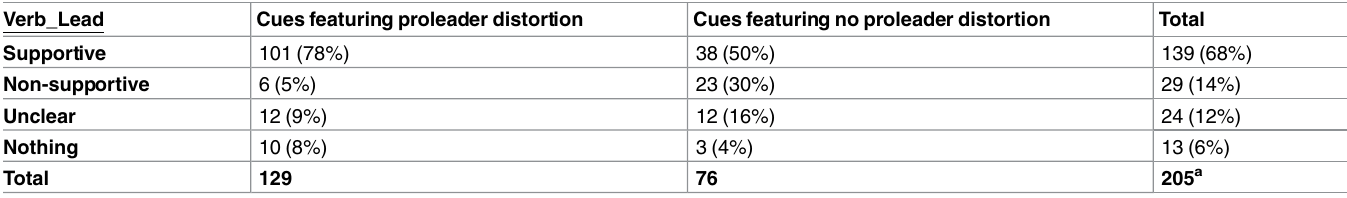
Table 3. Separate-scales group: frequency and proportionof codesassignedto verbalizations aboutthe leadingdiagnosis(Verb_Lead). Verb_Lead Cues featuring proleader